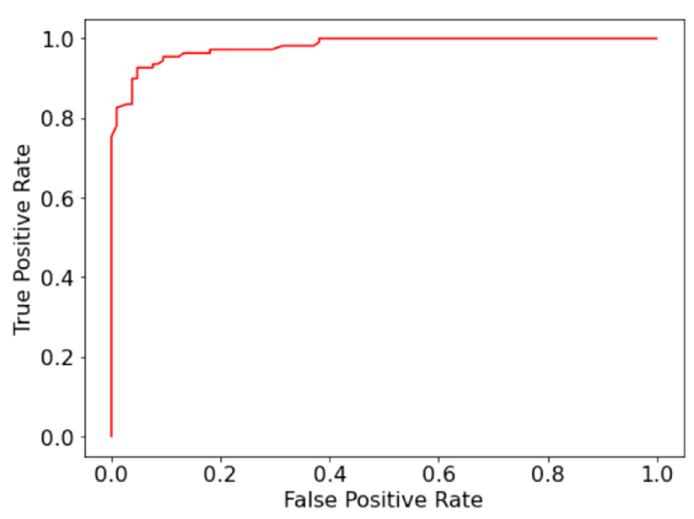
Figure 3. Receiver operating characteristic (ROC) curve for binary classification between immature and mature leukocytes.